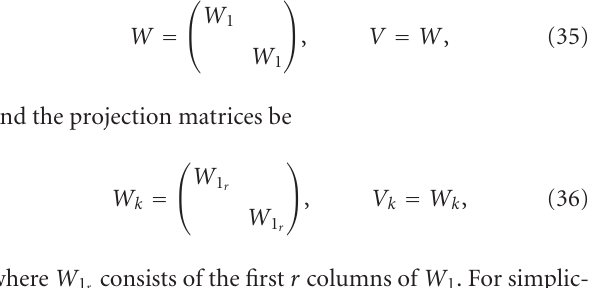
Algorithm 6 (Second-order model reduction—SVD on P